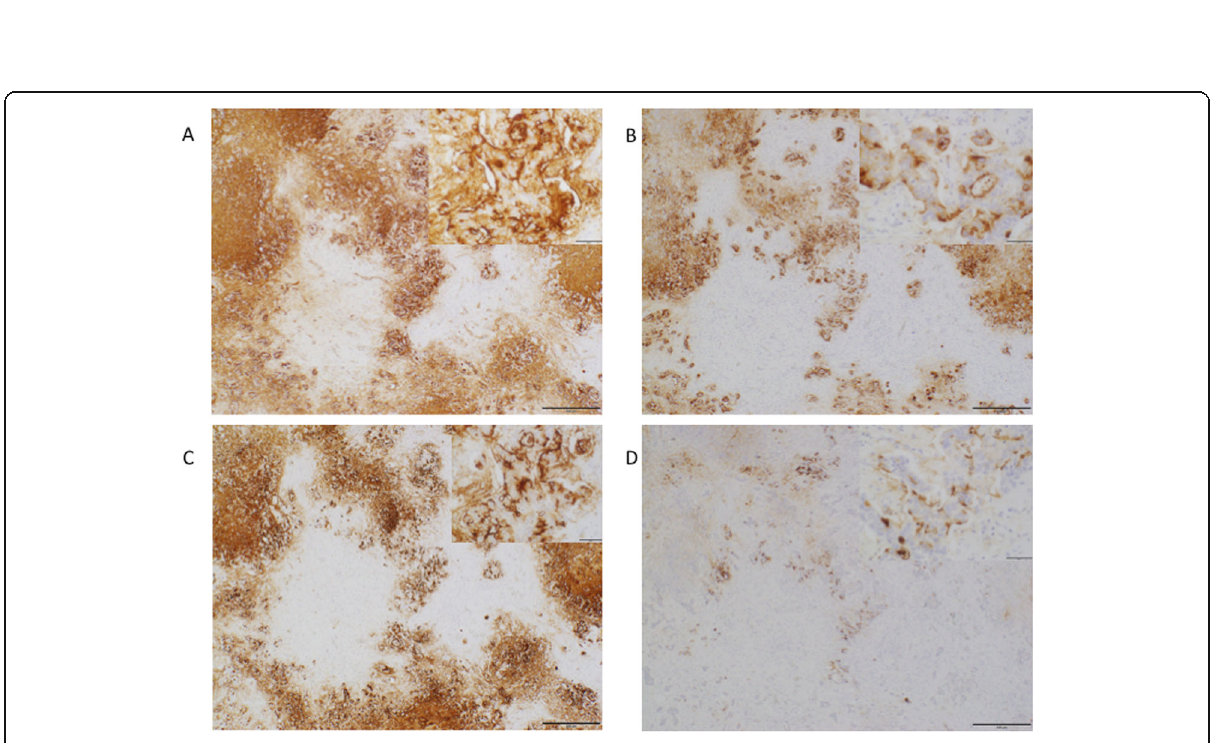
Fig. 3 Immunohistochemical findings. Immunohistochemistry for CA19-9 ( a ), CEA ( b ), MUC-1 ( c ), and CA125 ( d ). Magnification, × 40 and × 200. Note strong expression of CA19-9, CEA, and MUC-1 in the cytoplasm and membrane of cholangiocarcinoma cells. CA125 expression in the cytoplasm of cholangiocarcinoma cells is weak and partial. Scale bar 500 μ m and 50 μ m. CA19-9, carbohydrate antigen 19-9; CEA, carcinoembryonic antigen; MUC-1, cell surface-associated mucin 1; CA125, cancer antigen